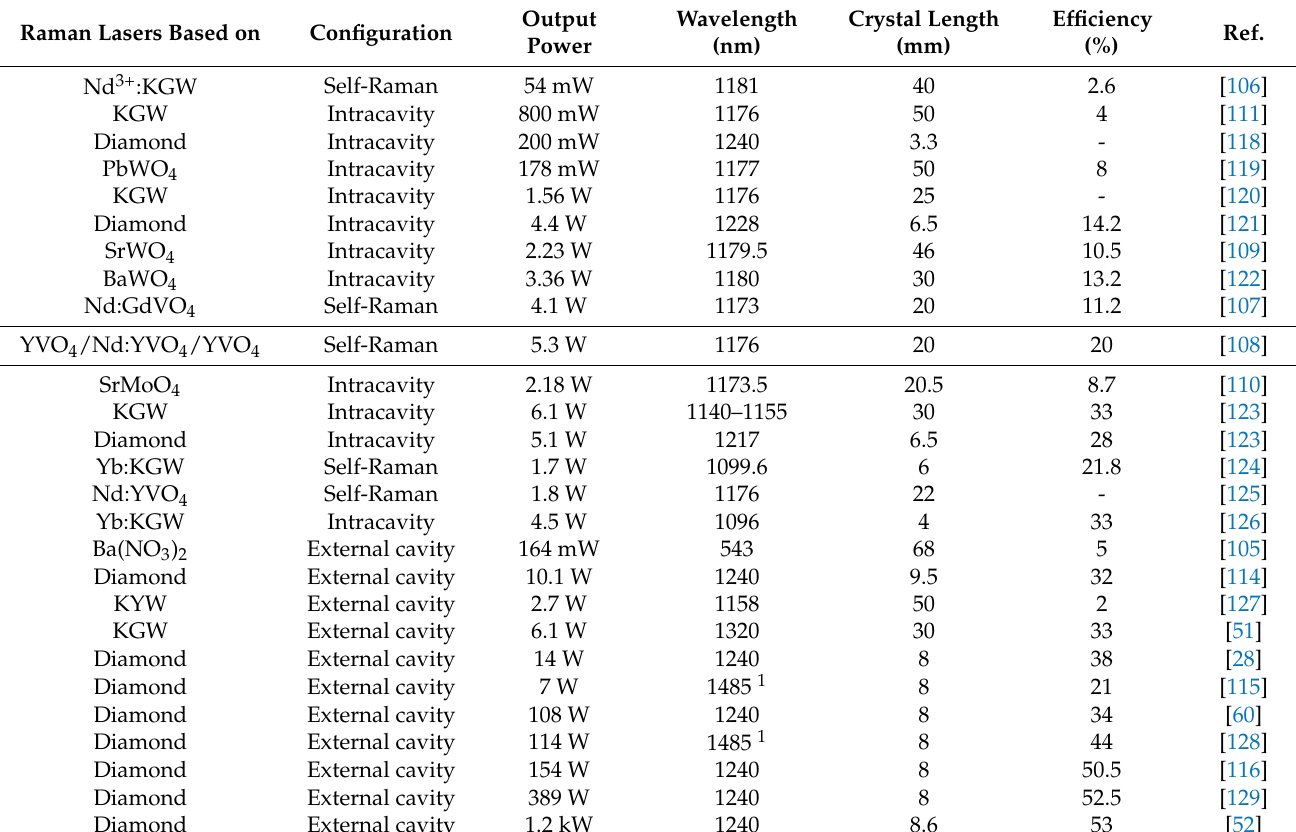
Table 3. Examples of several CW Raman lasers with performance